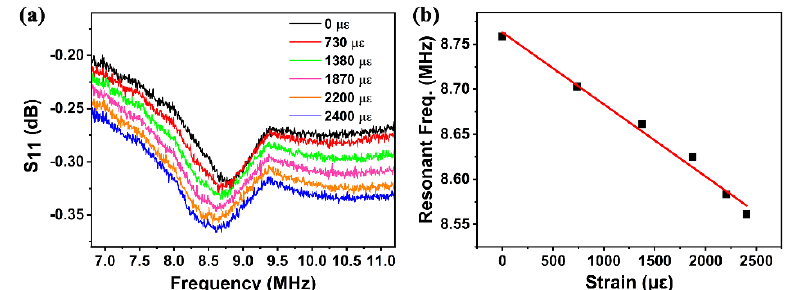
Figure 5. ( a ) Reflection spectra of device under different bending strains; ( b ) frequency shift as device strain function.